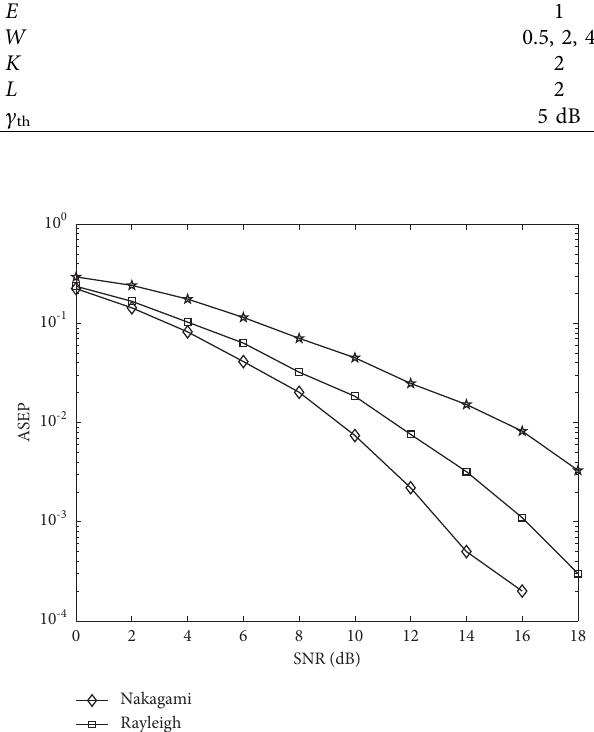
Figure 5: The ASEP performance comparison with different channel